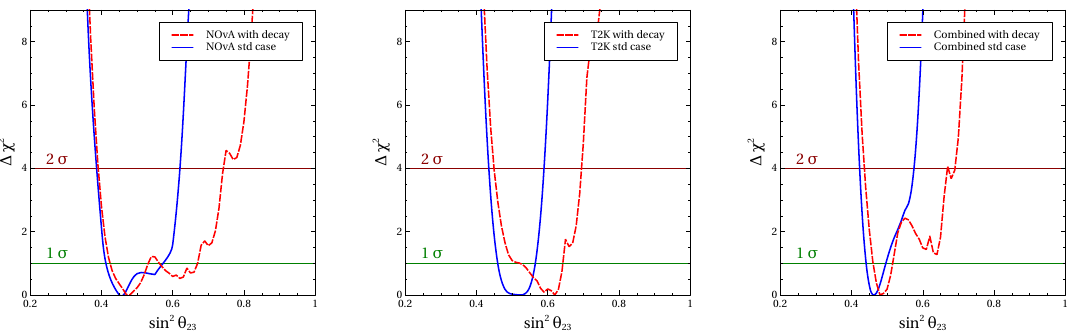
Figure 6 . (cid:1) (cid:31) 2 vs. sin 2 (cid:18) 23 , where the (cid:31) 2 is marginalised over all other parameters.